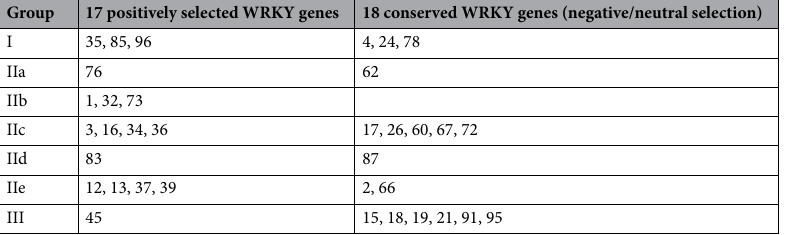
Table 2. Maximum likelihood estimation (Likelihood scores for tests for selection among codons of WRKY using site models implemented in PAML is detailed in Supplementary Table S5. Parameter estimates under models of variable ω ratios among sites for Oryza WRKYs are detailed in Supplementary Table S9) of selective pressure shows 17 single copy WRKY orthologs evolving under positive selective